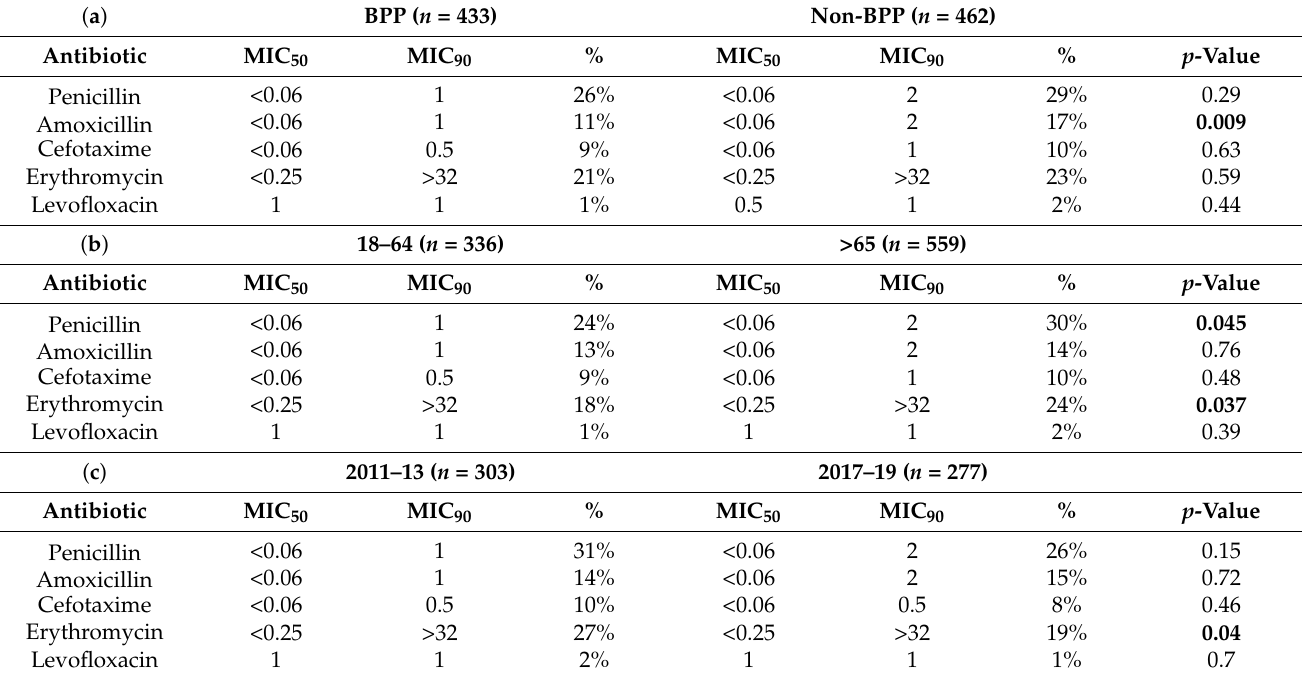
Table 2. Changes in antimicrobial non-susceptibility rates by type of infection ( a ), age group ( b ) and period ( c ). Percentages correspond to EUCAST clinical breakpoints of non-susceptibility for penicillin (>0.06 mg/L), amoxicillin (>0.5 mg/L) and cefotaxime (>0.5 mg/L) and resistance for erythromycin (>0.5 mg/L) and levofloxacin (>2 mg/L). Statistically significant results are highlighted in bold. MIC 50 and MIC 90 are given in